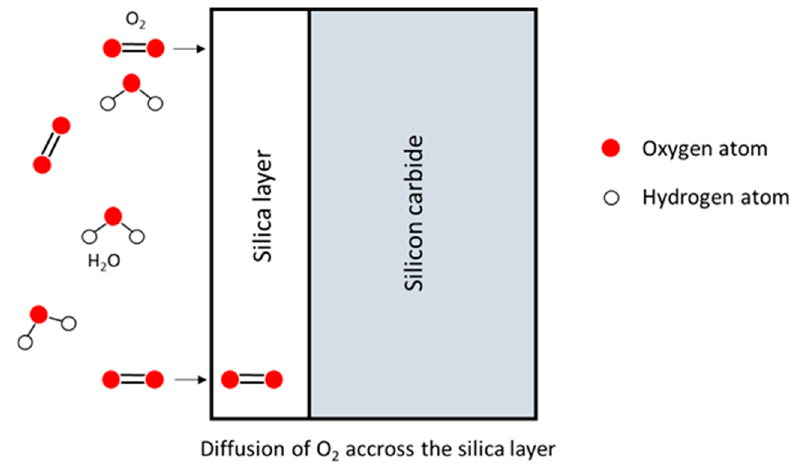
Figure 2. Scheme of diffusion of oxygen